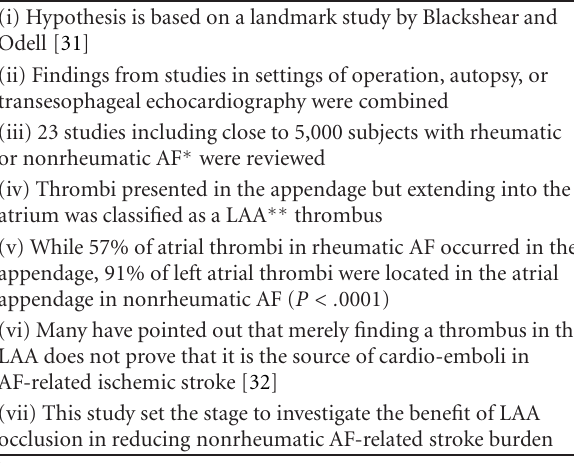
Table 2: Left atrial appendage as a source of thrombi in nonatrial